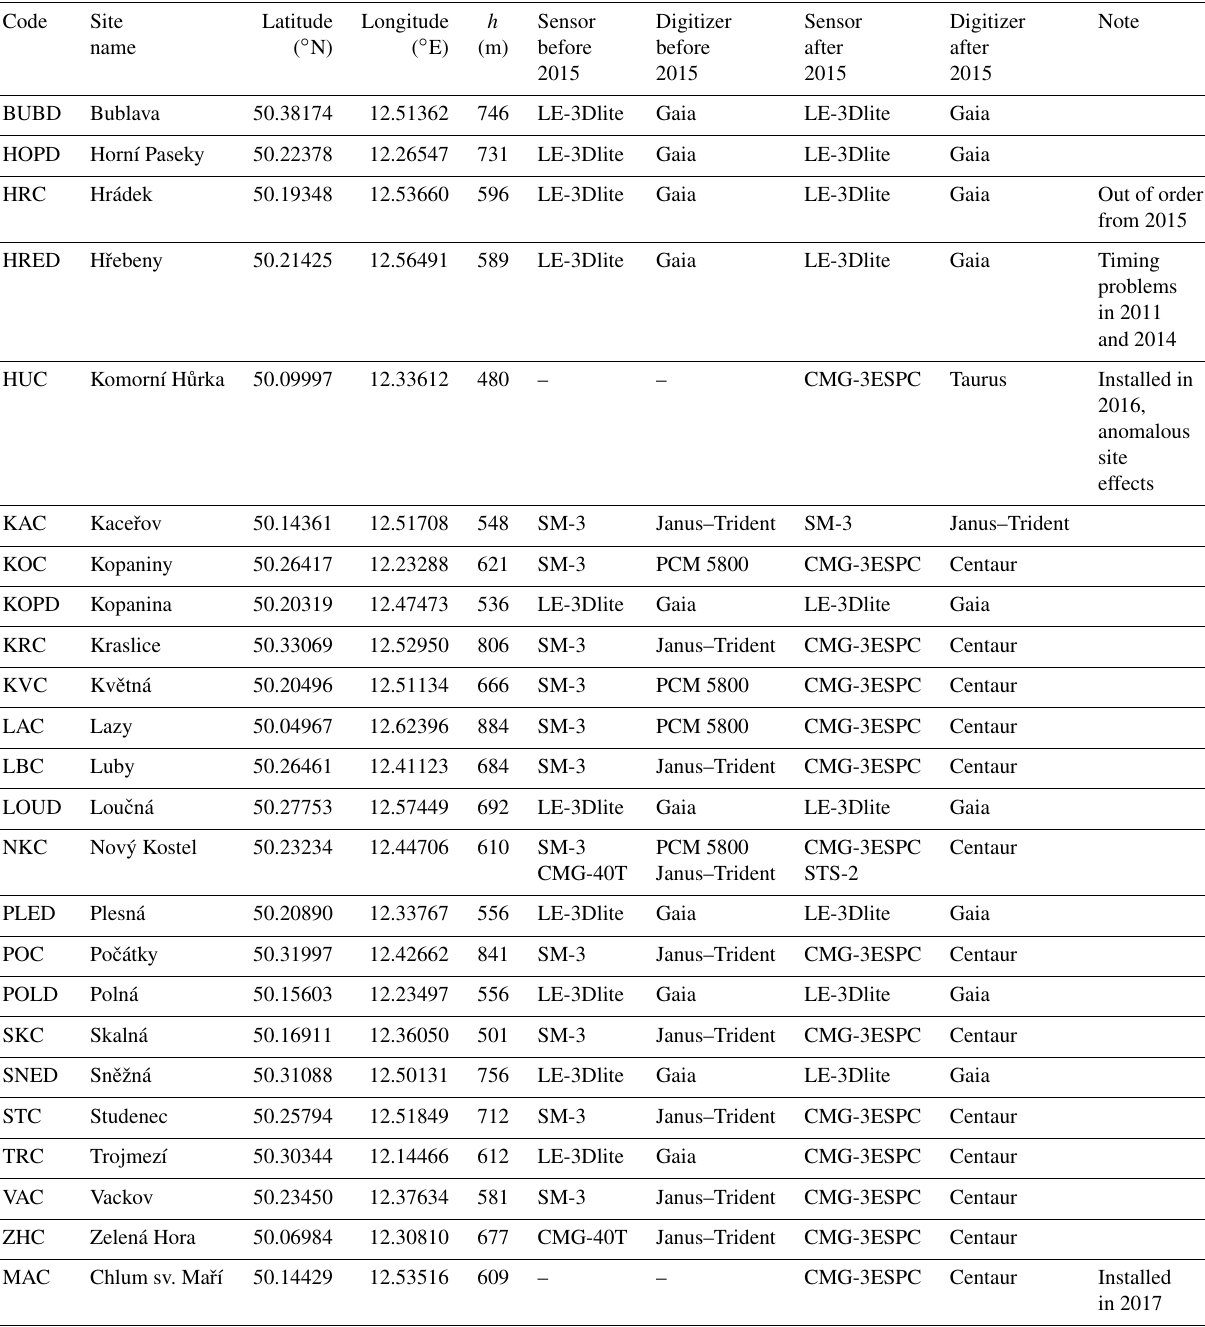
Table 1. Location and instrumentation of the WEBNET seismic